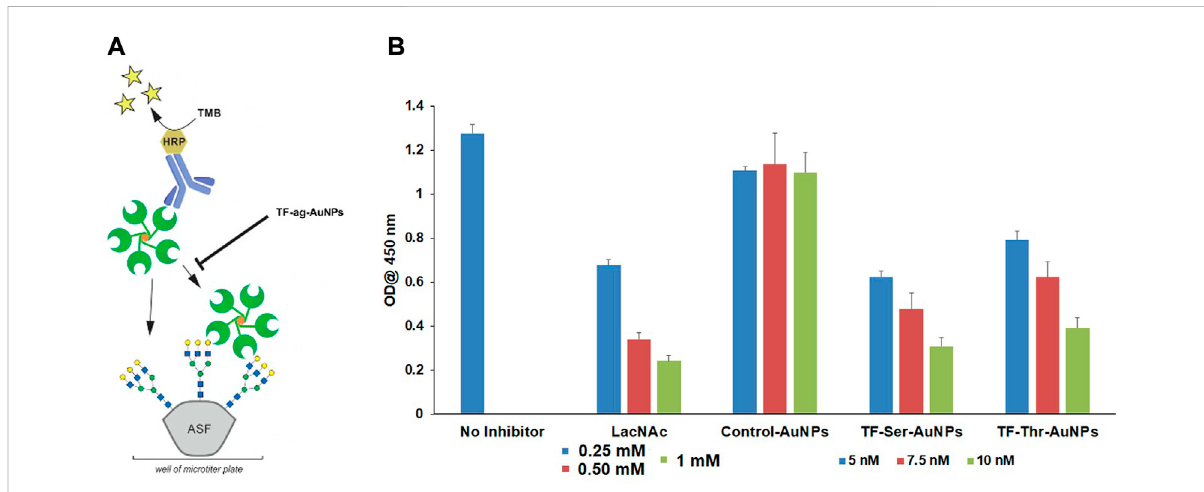
FIGURE 6 Inhibition of Gal-3 binding to ASF by TF ag -coated AuNP. (A) Schematic depiction of the assay as shown in reference (Otten et al., 2016). (B) Bar graph depicting inhibition of Gal-3 binding to ASF by compounds materials 12 – 14